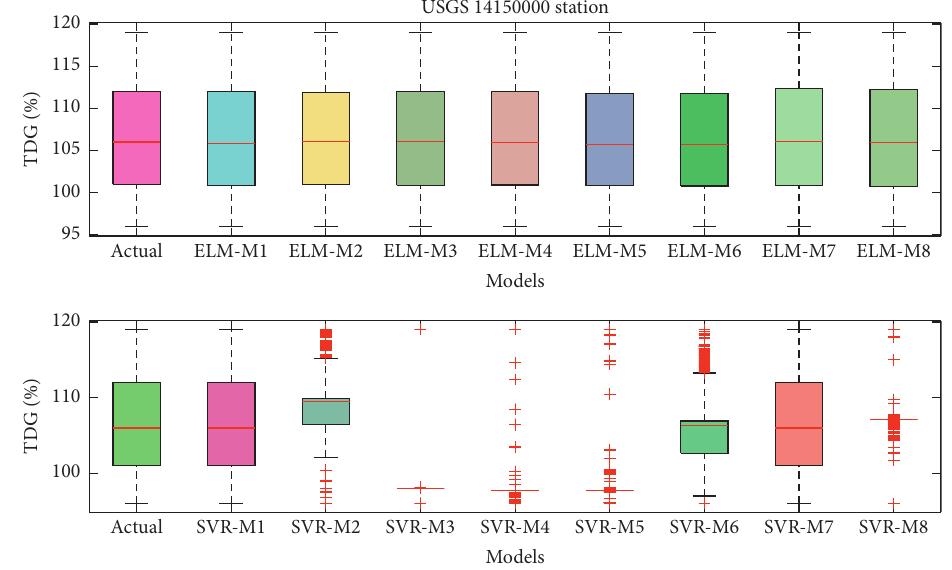
Figure 7: Boxplot presentation for USGS 14150000 station: (a) ELM and (b) SVR models.